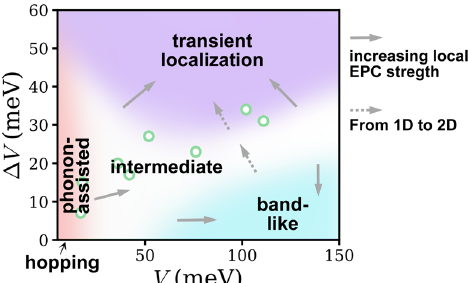
Fig. 7 A schematic “ regime diagram ” showing the phonon-assisted transport (PA) regime, transient localization (TL) regime, band-like (BL) regime, and intermediate regime on the ( V , Δ V ) plane for the carrier mobility of the Holstein – Peierls model. The hopping regime is achieved in the Δ V = 0 limit of the PA regime. Gray solid arrows show qualitatively the shift of the boundaries when local EPC increases. Gray dashed arrows show qualitatively the shift of the boundaries when transport network changes from one dimension to quasi-two-dimension or equivalently when electronic coupling isotropy increases. The green dots represent the V and Δ V of several common organic